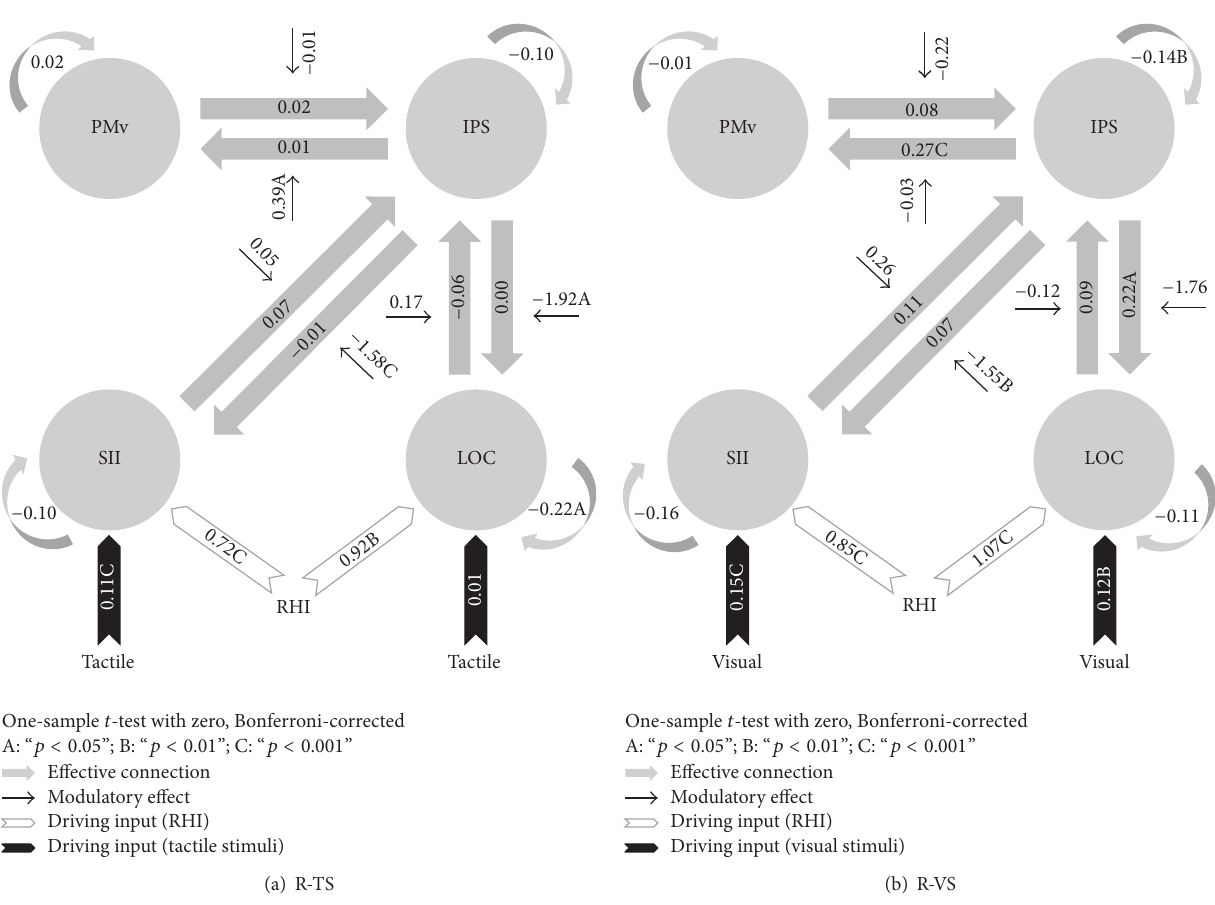
Figure 3: (a) BMAresults of recovery from theRHI by needle rotation in thereal hand (R-TS condition). (b) BMAresults of recovery from the RHI by needle rotation in the rubber hand (R-VS condition). Means of parameter estimates from all participants for endogenous connection (DCM.A), modulatory effect (DCM.B), and driving input (DCM.C) and statistical significance are shown. A one-sample t -test with zero was used to assess statistical significance and the Bonferroni correction was applied for multiple